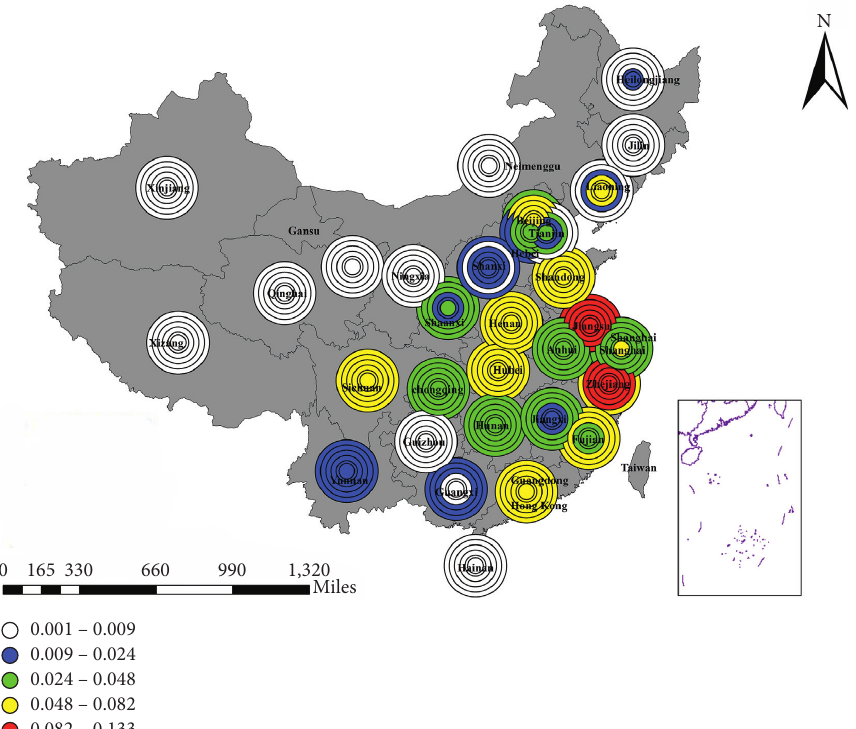
Figure 2: Time and space distribution of China’s construction industry. Note . From the inside to the outside, each circle represents the period from 2010 to 2019, respectively. The proportion of construction output value decreases successively according to red, yellow, green, blue, and